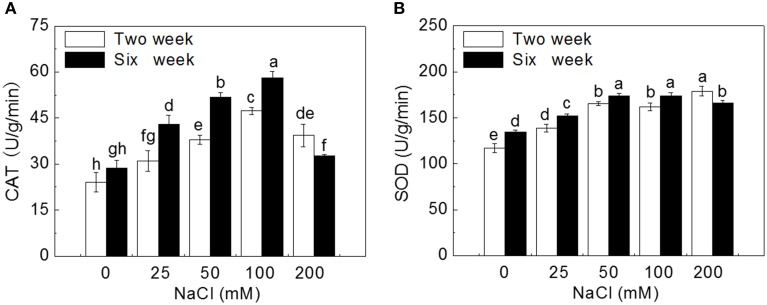
Effects of NaCl treatment on activities of catalase (CAT) and superoxide dismutase (SOD). (A) CAT activity, (B) SOD activity. Values are means and bars indicate SDs (n = 6). Columns with different letters indicate significant difference by Duncan's multiple range tests at P < 0.05.